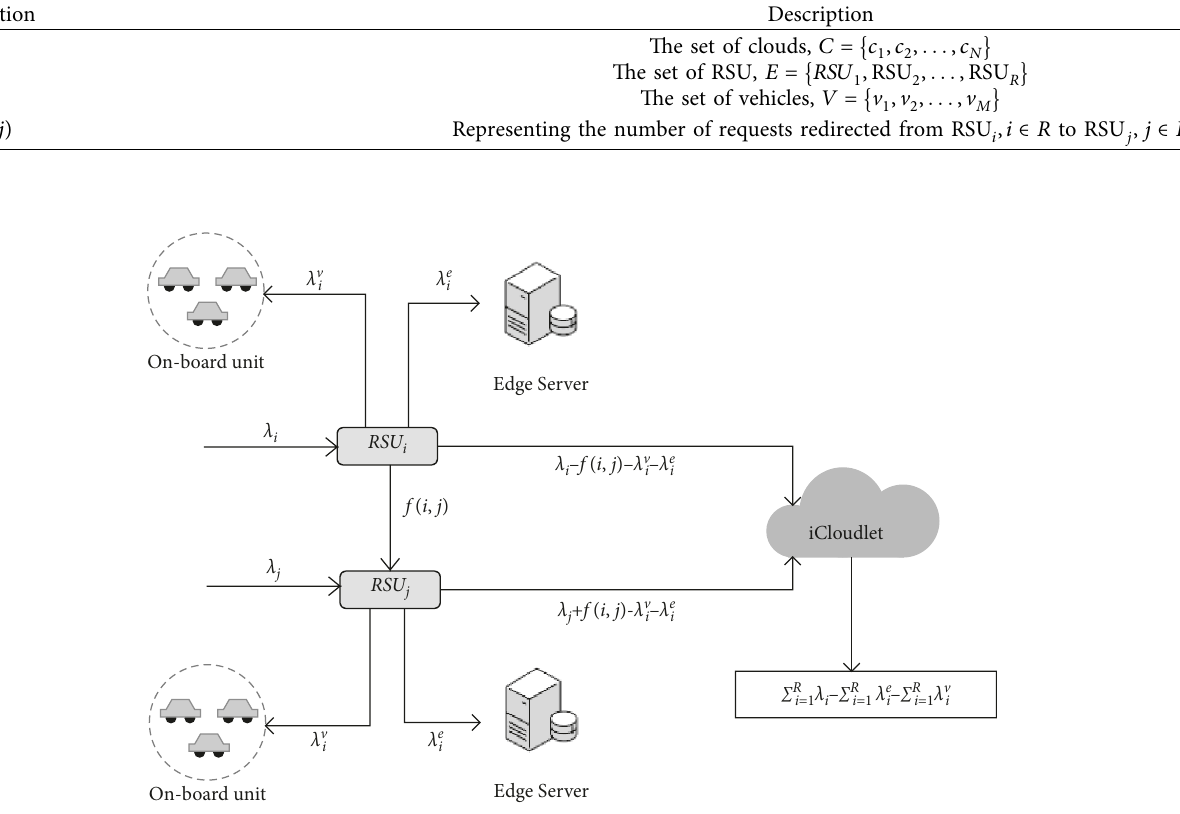
Figure 3: Distribution diagram of the vehicular